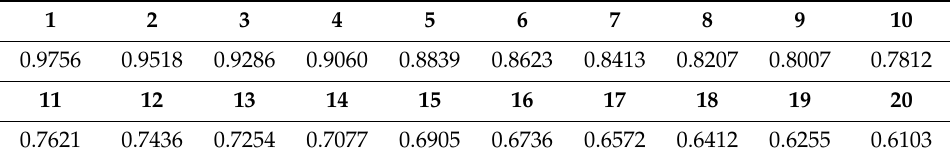
Table 11. PVSP (20 year, 2.5%).